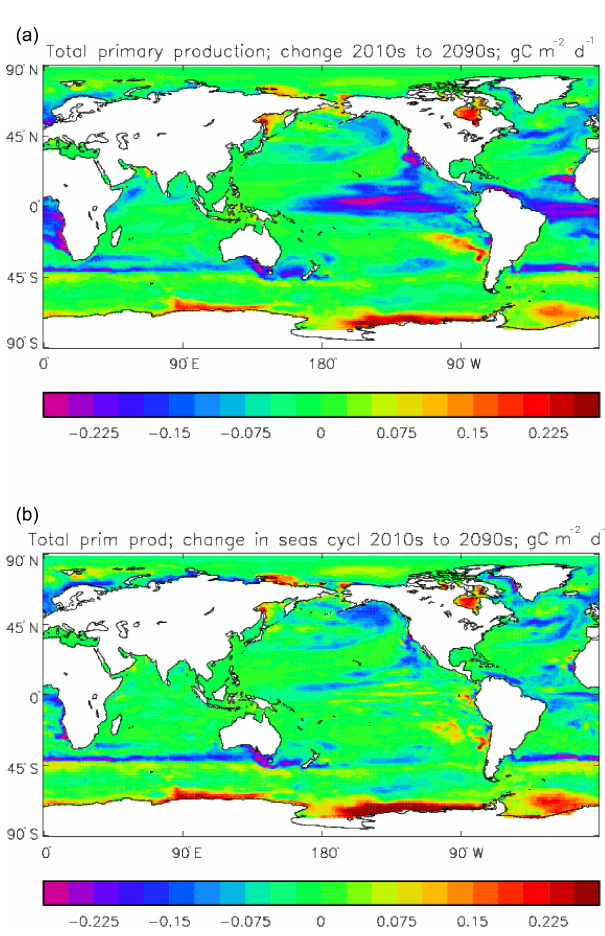
Figure 37. Change in the depth-integrated total primary production (mgCm − 2 d − 1 ) in the RCP8.5 simulation: difference between the model years 2090–2099 and 2010–2019. (a) Difference in decadal means; (b) difference in the amplitude of the mean seasonal cycle.